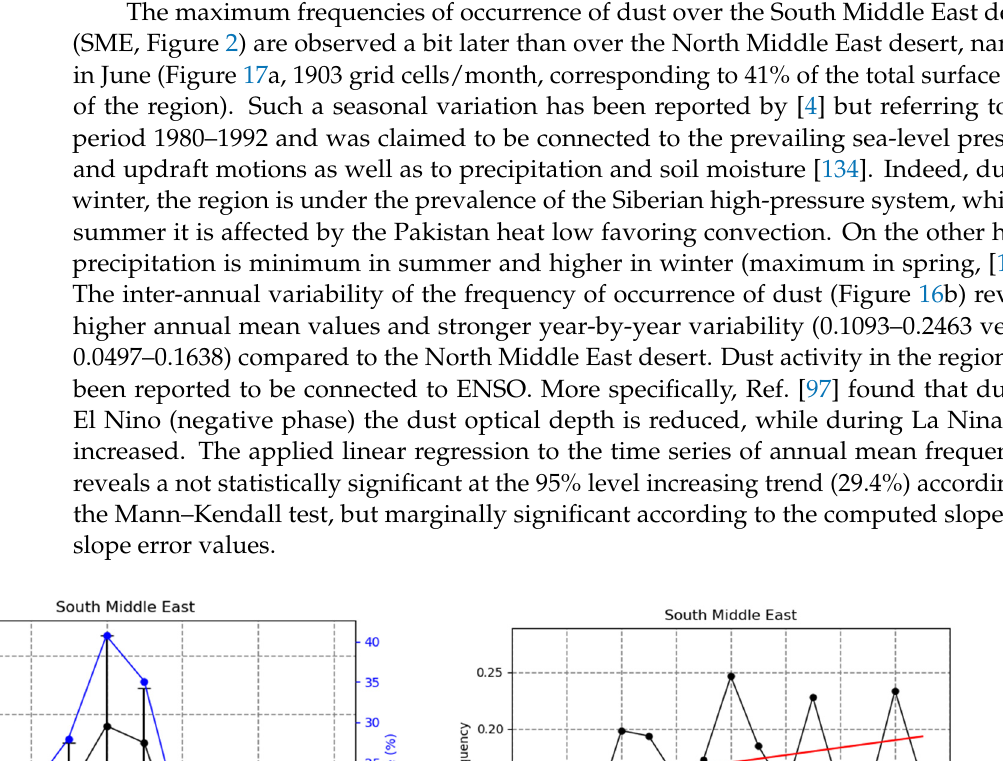
Figure 16. ( a ) Intra-annual variability of the 2005–2019 averages of the total absolute number of grid cells (1° × 1°) where dust aerosols (DA) were detected over North Middle East by the satellite algorithm (left axis) and the percent coverage of the region by dusty grid cells (right axis). The error bars represent the year-by-year variability by means of computed 2005–2019 standard deviations. ( b ) Inter-annual variability and linear trend of the relative frequency of dust aerosols (DA) over North Middle East.